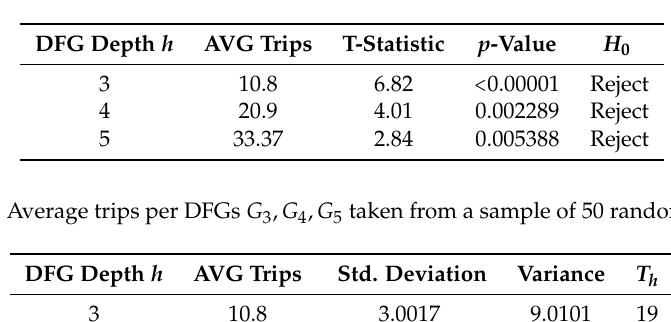
Table 5. T-statistics for each DFGs G 3 , G 4 , G 5 with the samples. For each row, we have tested H 0 against the results.